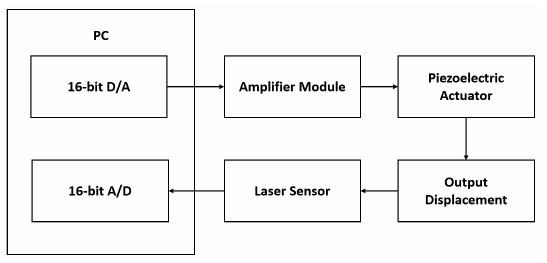
Figure 7. Experimental